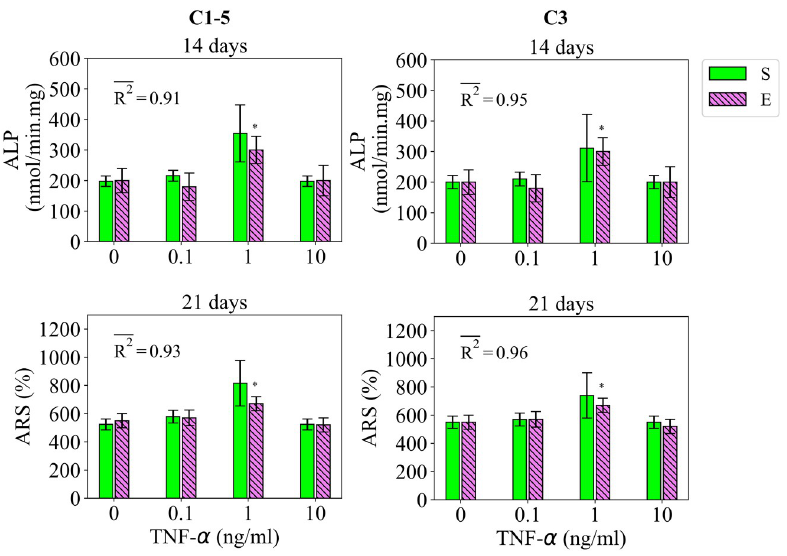
Fig 5. Fits of the model calibrated by C1-5 and C3 to the empirical data of study 3 for the case of TNF- α . Bars indicate the simulations (S) and the corresponding empirical data (E). The quantities of ALP and ARS are reported at day 14 and 21, respectively. The error bars on the empirical data shows the standard deviations. The error bars on the simulation results show the standard deviations obtained during SSIP, i.e. 15% alteration in the estimated parameter values. Stars indicate the statistically significant differences between values given for the empirical data compared to the control, i.e. the applied concentration of 0 ng/ml (p < 0.05 = � ). R 2 is the average fitness value of the simulations for the given measurement item.